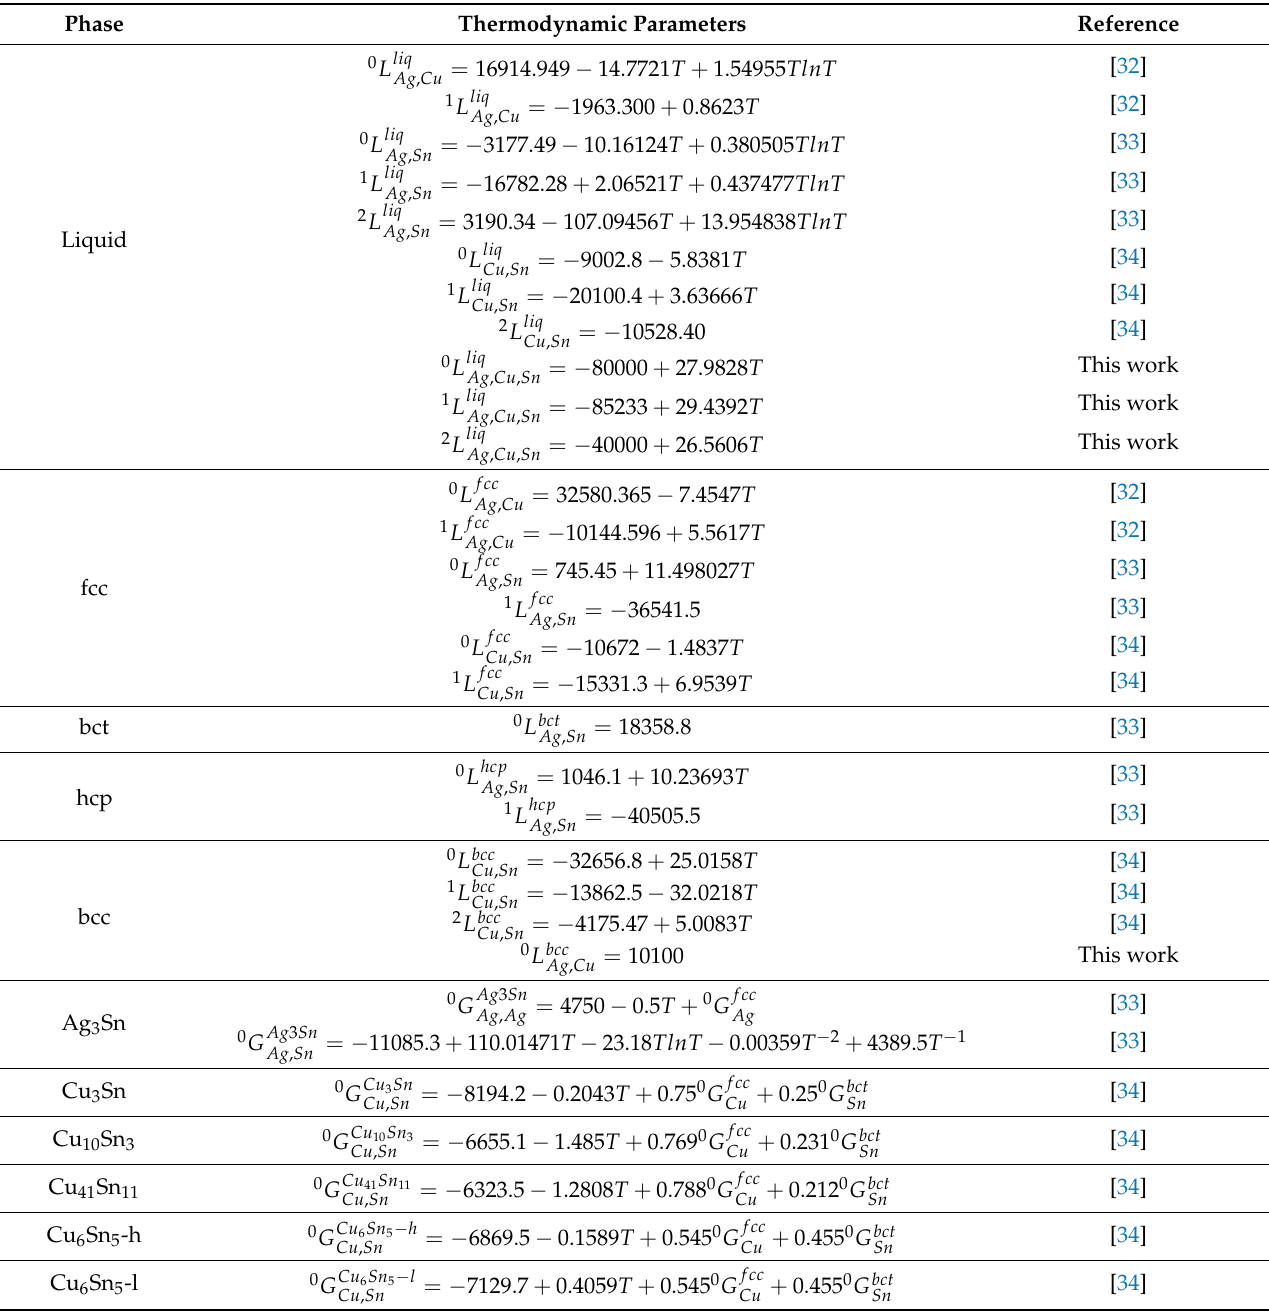
Table 2. Thermodynamic parameters for the Ag-Cu-Sn ternary system. Phase Thermodynamic